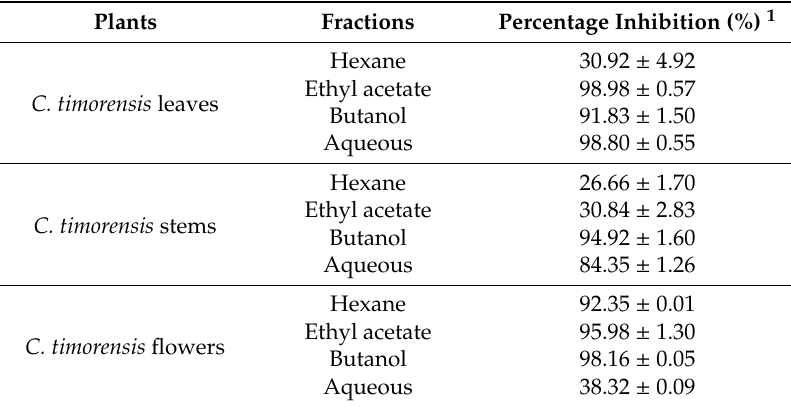
Table 2. Percentage inhibitions of C. timorensis fractions at 0.2 mg / mL.